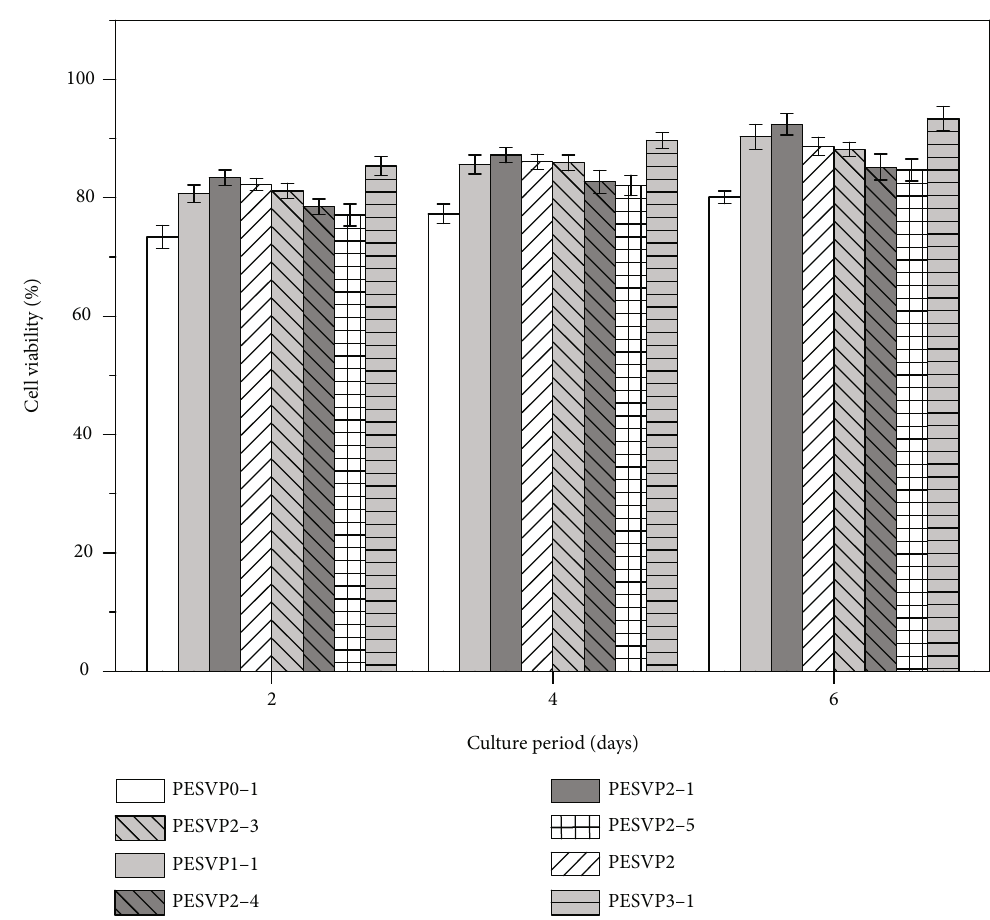
Figure 10: Viability of cells on the PESVP membranes measured by MTT Table 5: Comparison of the performance of di ff erent PES hemodialysis membranes.